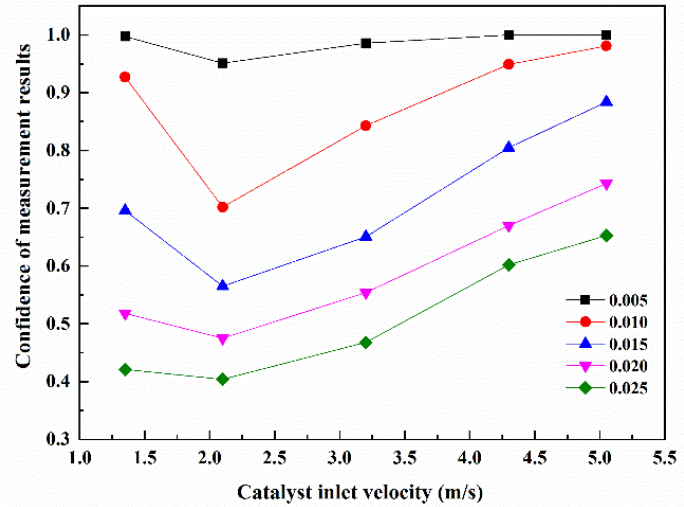
Figure 24. Relationship between mean velocity and the confidence of the measurement results under different relative standard deviations of temperature at deviation grade standard 0.25.